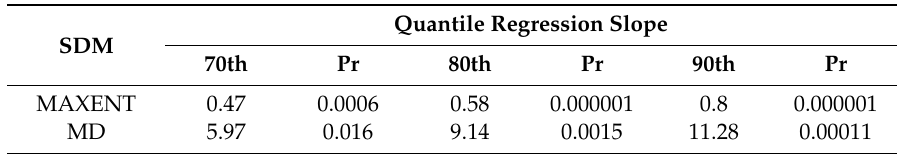
Table 4. Results of the top three quantiles (70th, 80th, 90th) for the quantile regression of the normalized cell tenure (NCT) values on SDM model scores. Results of the quantile regression indicate that our NCT values are well correlated with the SDM modeled suitability